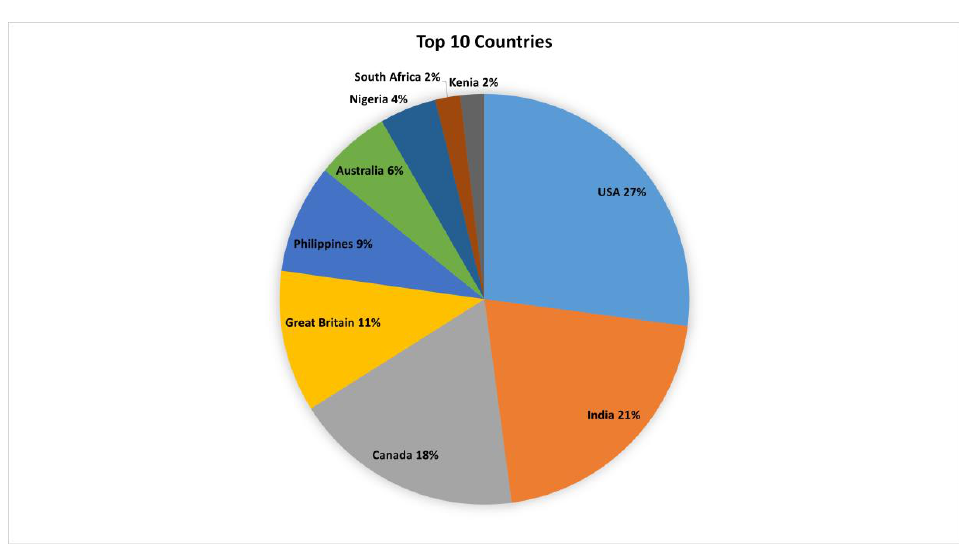
Figure 6 Figure 6. Top 10 countries. Page administrators from the top 10 countries of